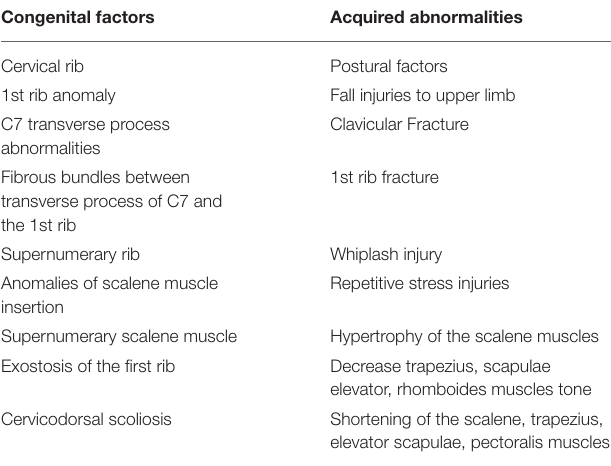
TABLE 1 | Common causes of TOS. Congenital factors Acquired abnormalities Cervical